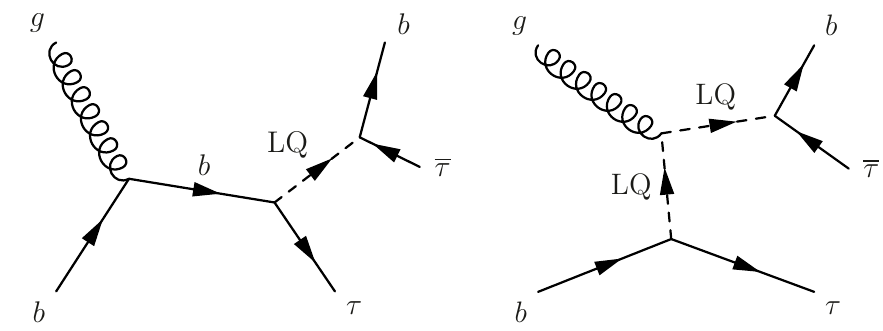
Figure 1 . Leading order Feynman diagrams for the single production of third-generation LQs subsequently decaying to a (cid:28) lepton and a bottom quark, for the s -channel (left) and t -channel (right)